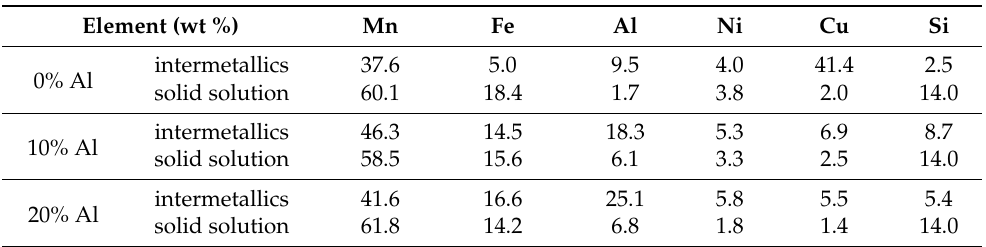
Table 7. Elemental composition of intermediary phases and the matrix formed by the solid solution (SEM/EDS).